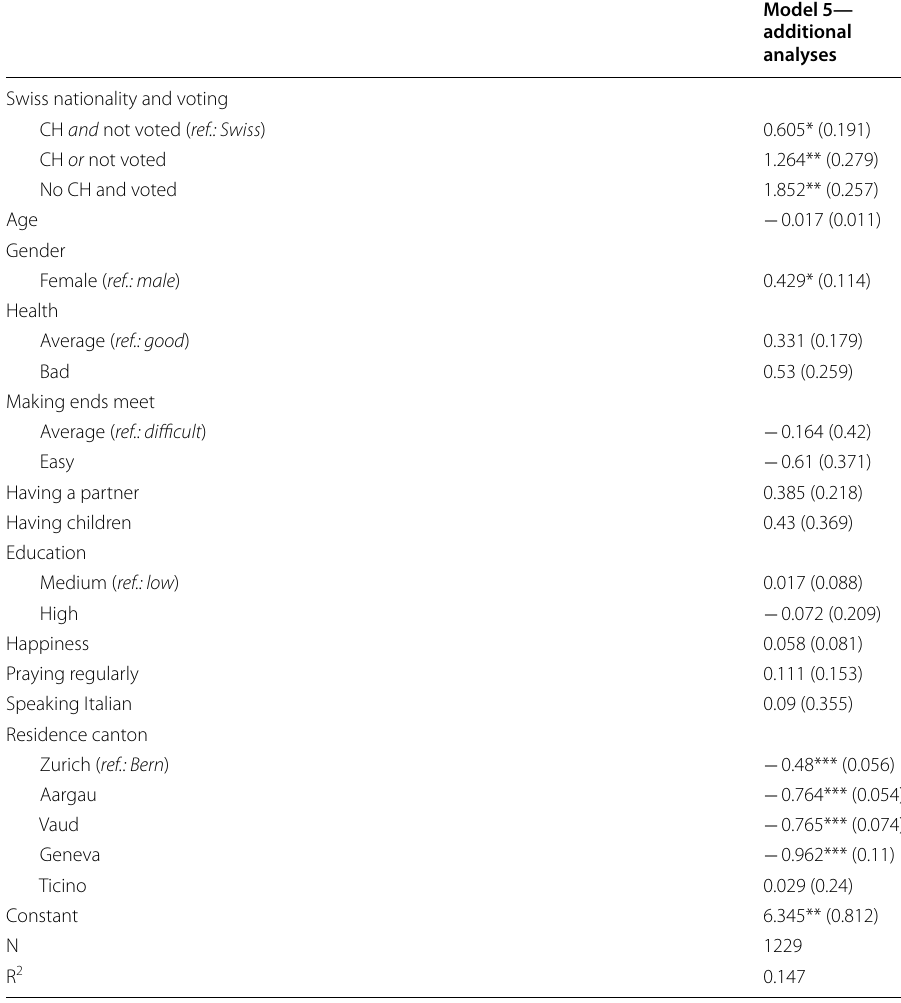
Table 6 Additional analyses: linear regression to test voting and Swiss nationality on worry about the